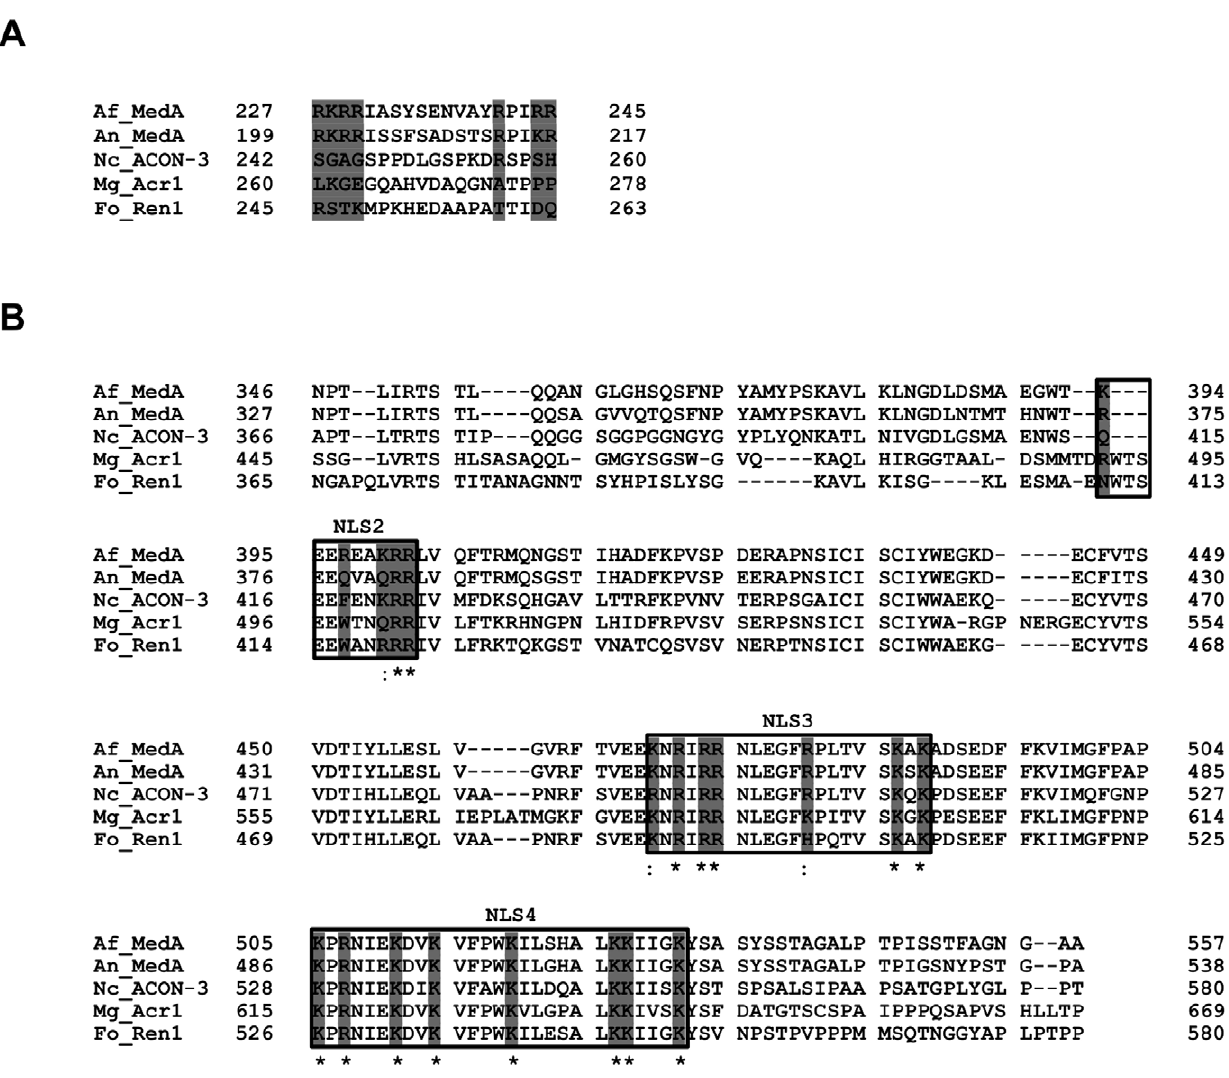
region and the first 282 bp of medA coding sequences was amplified from A. fumigatus genomic DNA using the primers PmedA-F and MedA-NheI-R. This PCR product was digested with NheI and NruI and subcloned upstream of the medA open reading frame of the pMedA-GFP plasmid, after NheI and EcoRV digestion. The resulting plasmid was designated pPmedA-MedA-GFP. The medA(p) sequences were released from this plasmid by NheI and AgeI digestion and used to replace the alcA promoter upstream